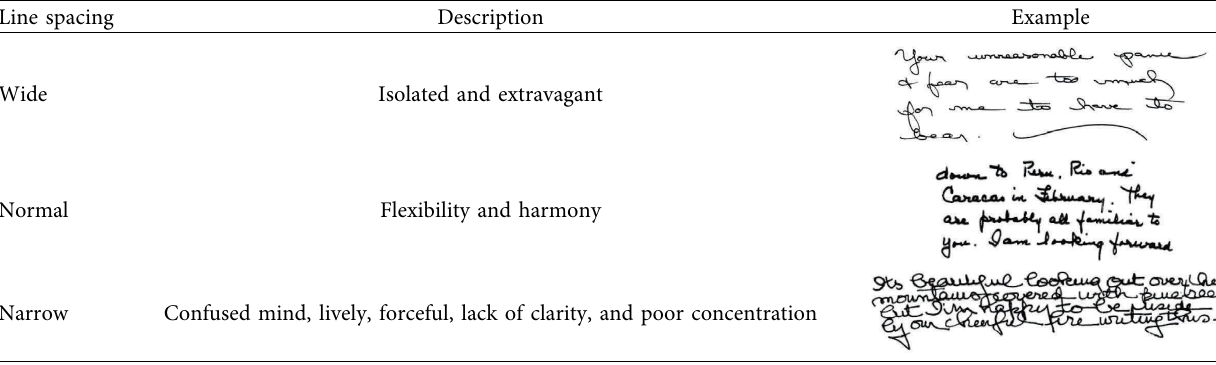
Table 4: Te line spacing features and their corresponding